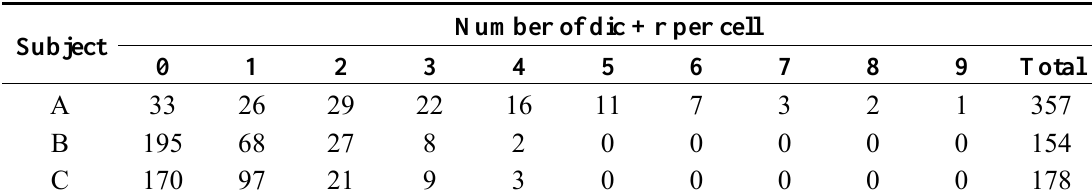
Table 2. The distribution of “dic + r” in